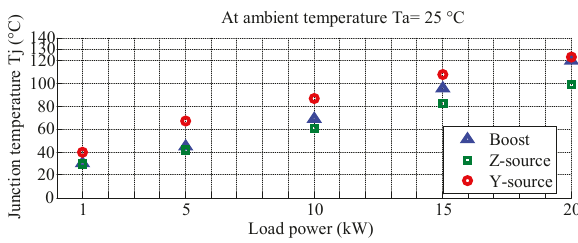
Fig. 7. Junction temperature variation of the switch at different power loading and using a voltage gain of 4.